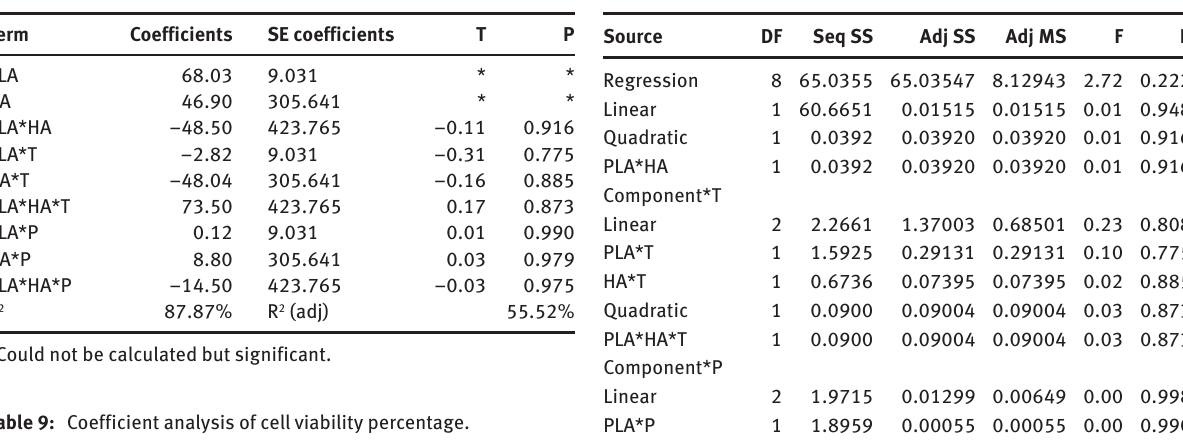
Table 8: Coefficient analysis of flexural strength.